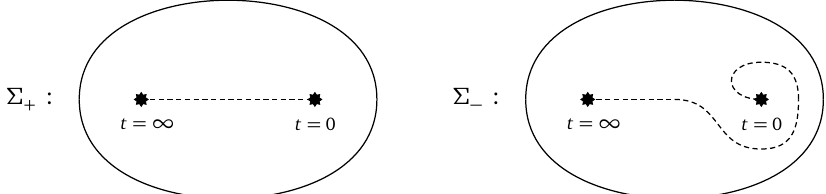
Figure 6: Branch-cut structure for the two N = 1 curves for su ( 2 ) SYM. The figures show the projections of the N = 1 curves onto the Gaiotto curve (parametrized by t ). The right hand figure is related to the left by a Dehn twist. These two curves characterize the two vacua of the